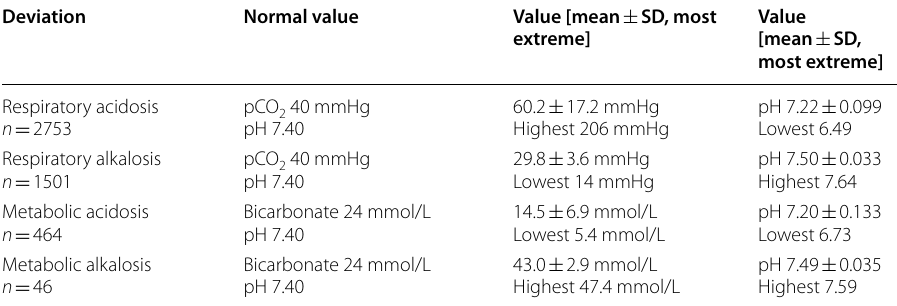
Table 3 Levels of deviation for the different disturbances Deviation